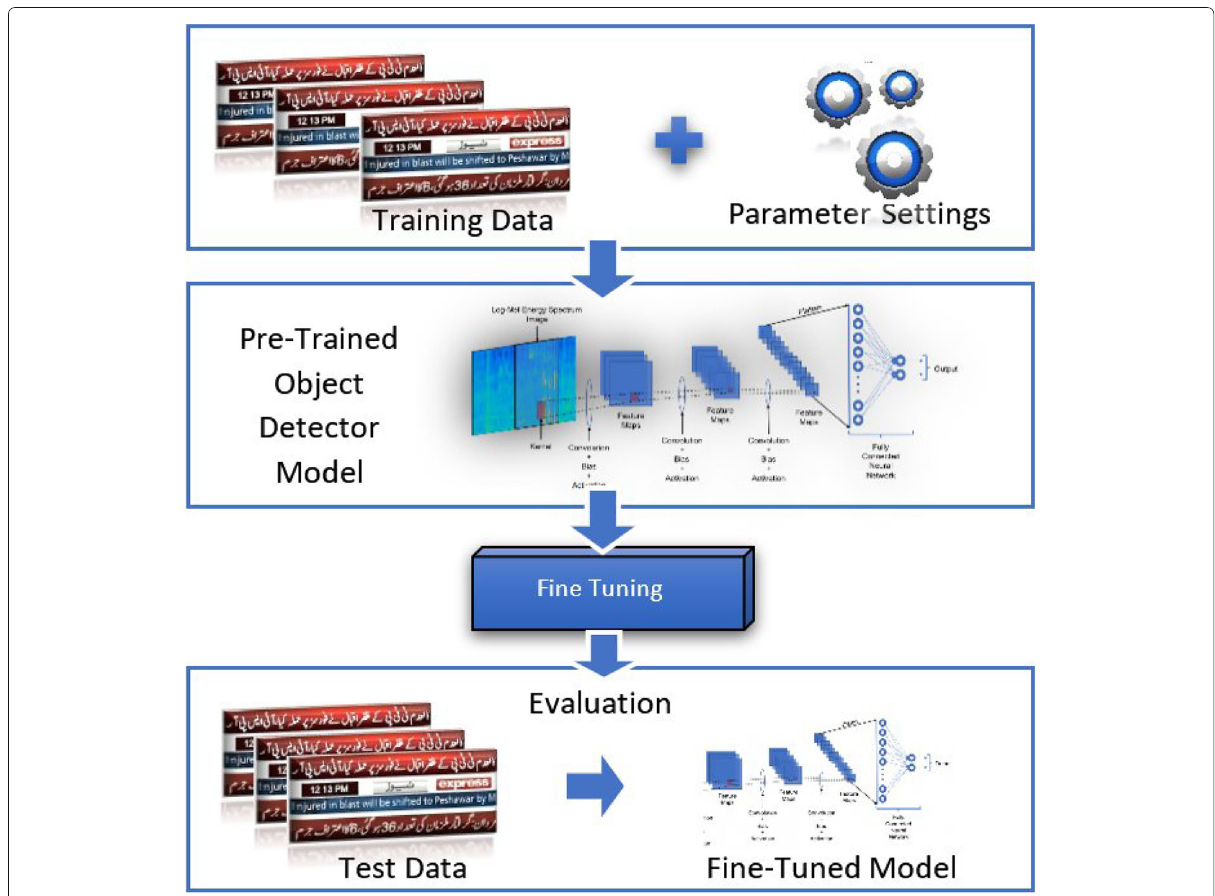
Fig. 7 Overview of fine-tuning object detectors for text